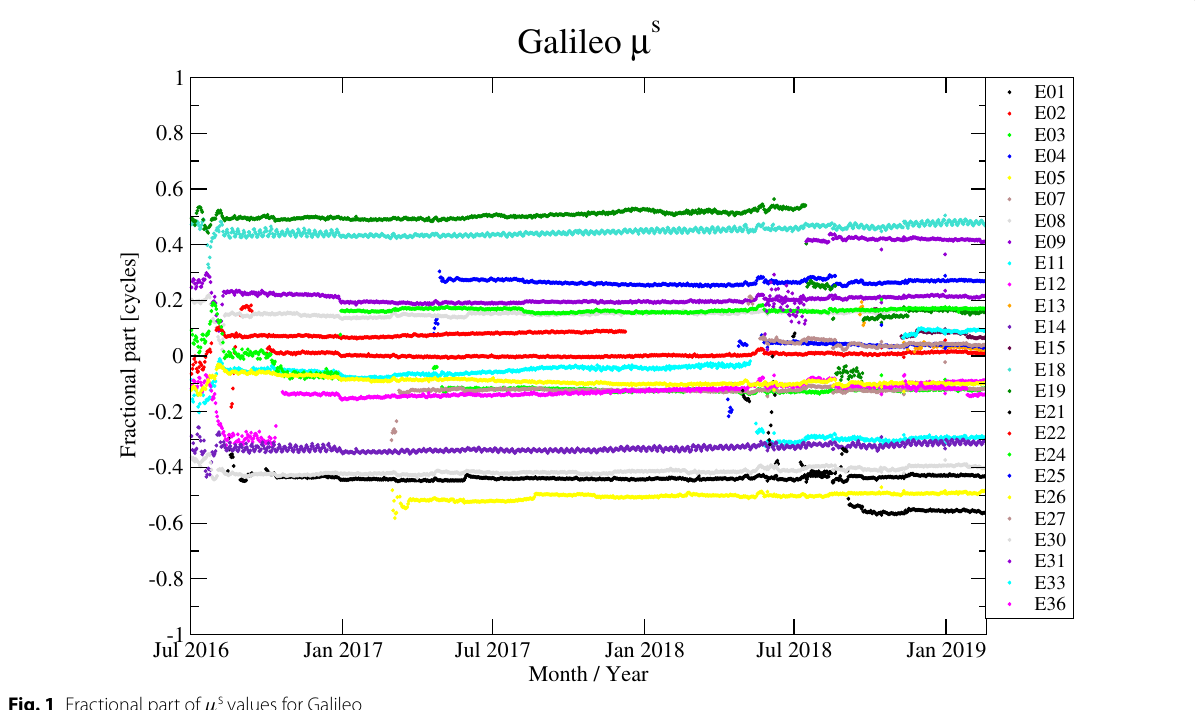
Fig. 1 Fractional part of µ s values for Galileo